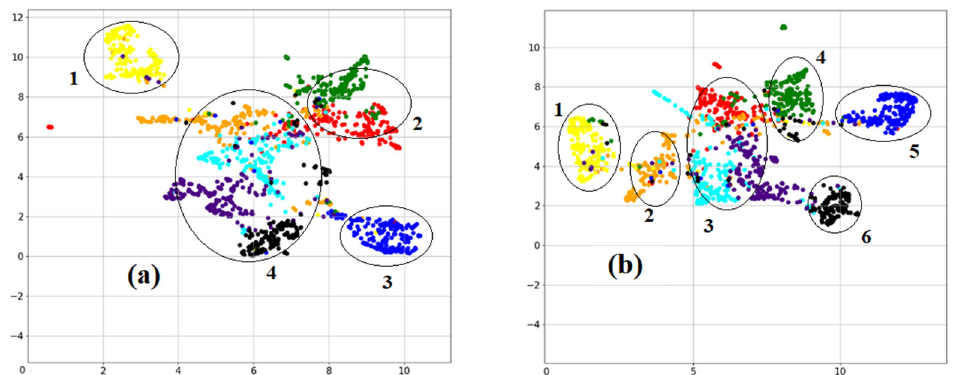
Figure 5. Graphical representation of the cosine metric values for the marked corpus of documents with two different TF-IDF presentations using node/term degrees in semantic document networks: ( a ) the occurrence frequency of an object in the document (2) and the smoothed inverse document frequency (5) (here 1, 2, 3, 4 are the numbers of clusters); ( b ) the double normalized occurrence frequency of an object in the document (3) and the inverse document frequency (4) (here 1, 2, 3, 4, 5, 6 are the numbers of clusters).